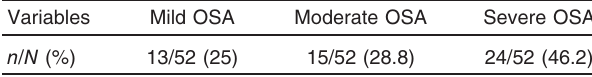
Table 2 Severity of obstructive sleep apnea among the studied diagnosed 52 patients according to apnea – hypopnea